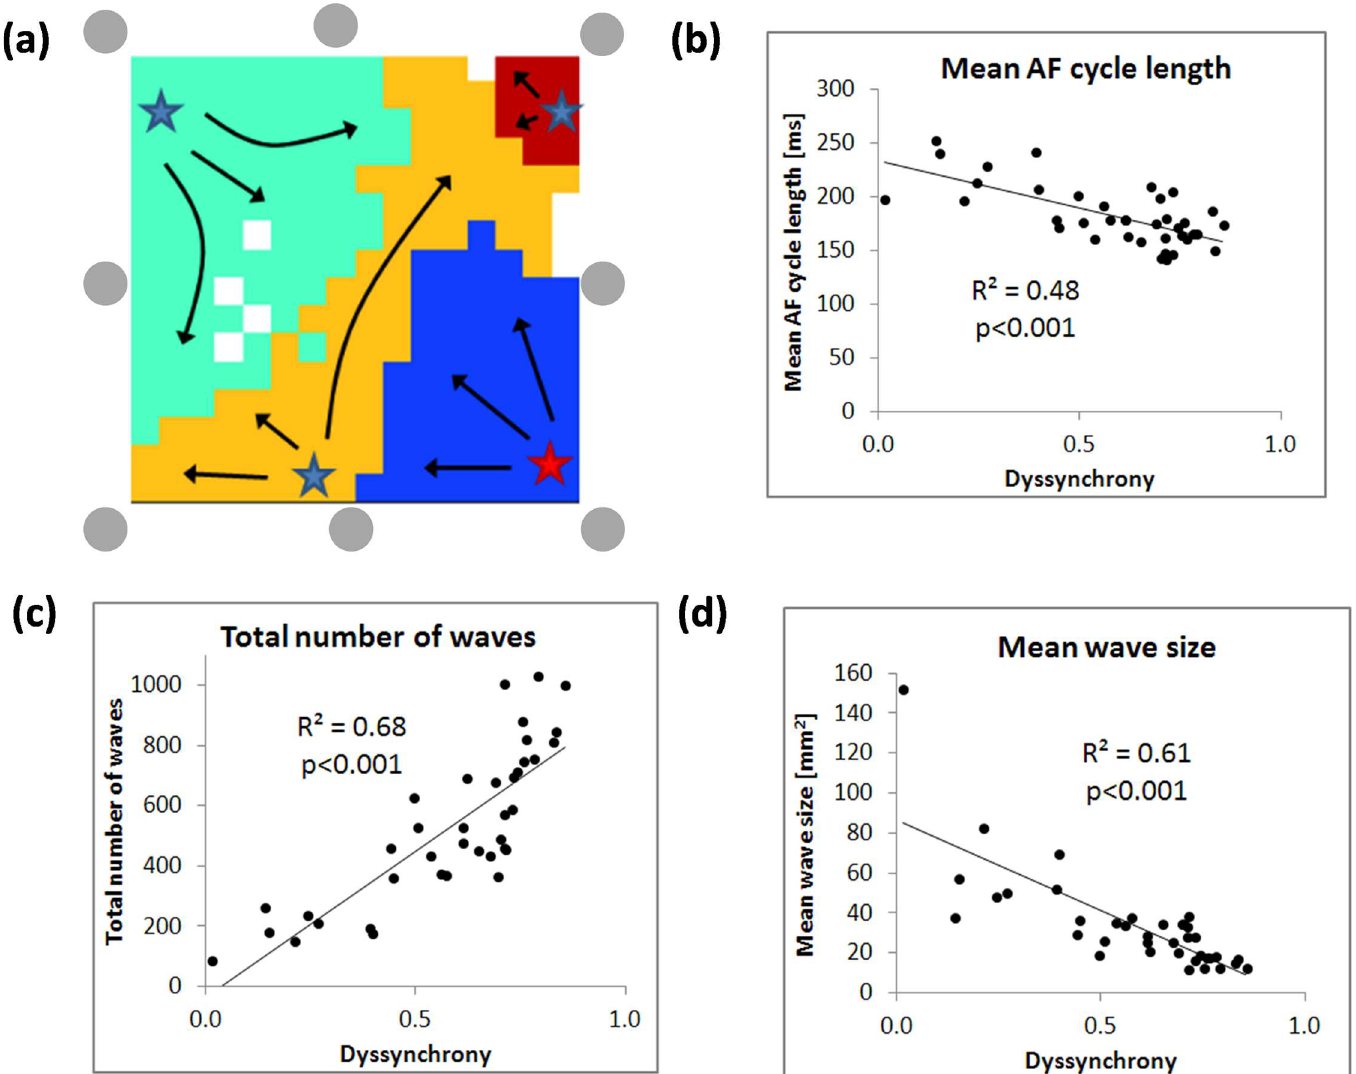
Fig 2. Correlation of electrical dyssynchrony and wave characteristics derived from high-density epicardial mapping. (a) An example of individual waves identification (each wave denoted in a different color) in mapped field. Electrical dyssynchrony was calculated using a subset of electrodes with positionsindicatedby gray circles resulting in comparablelayout as in a case of the circular catheter. Relationof the mean dyssynchrony between given subset of electrodesand mean AF cycle length (b), the total number of waves detected during whole recording (c) and the mean size of detected waves (d). Each point in the plot represents a mean value from single 10 s recording. Each point in the graphs (b-c) denotes an estimate from a single